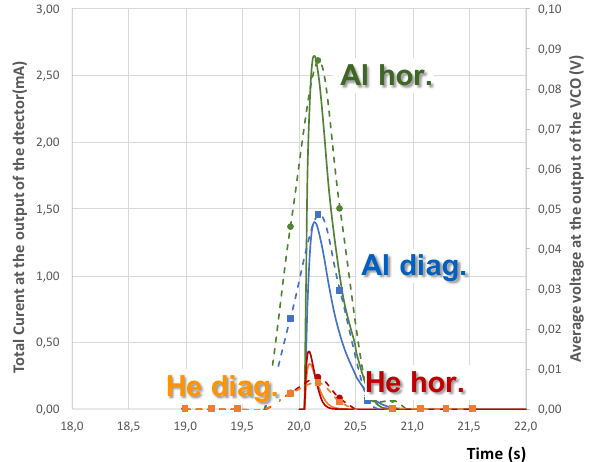
Fig. 20. Current at the bottom contact of the pixel (full line curves) and corresponding average voltage (dotted line curves) versus time.